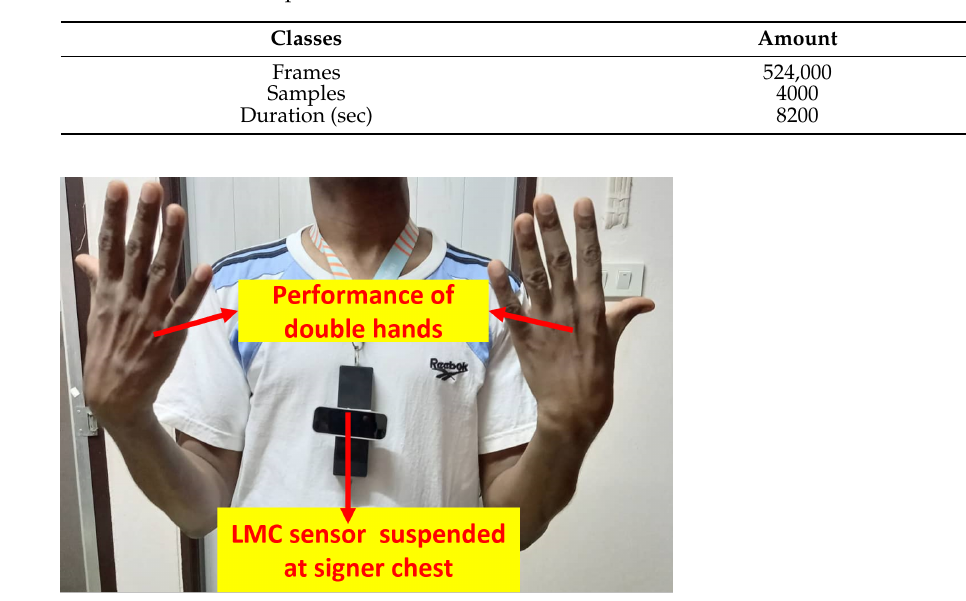
Table 6. Dataset description.